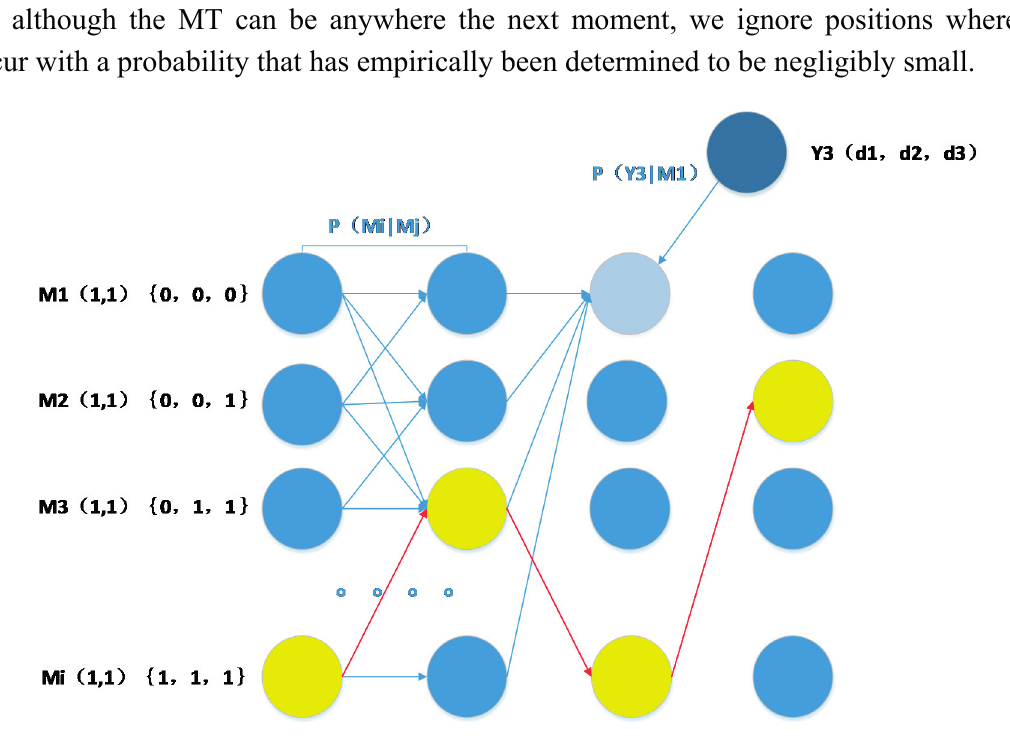
Figure 5. Flow diagram of